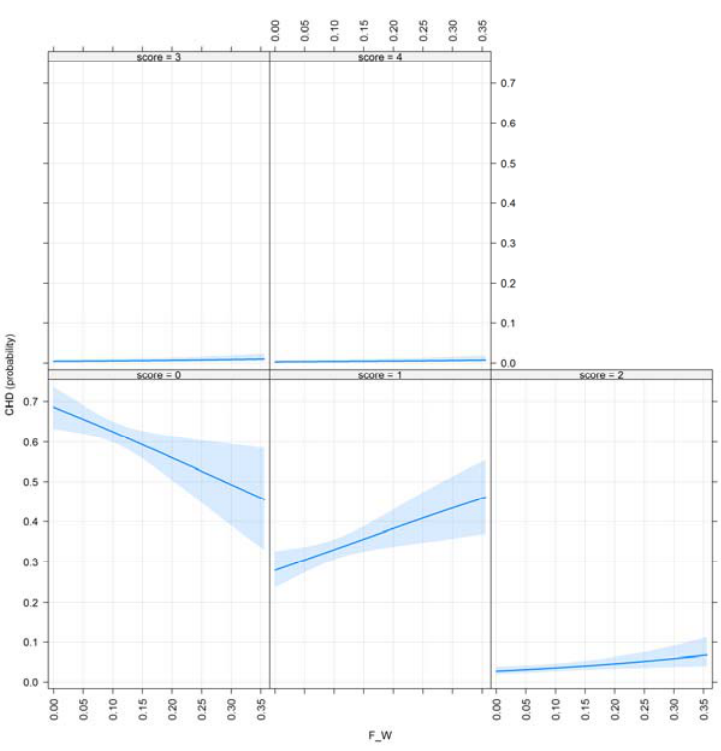
Figure 4. Effect plot of F _W for CHD, where scores from 0–4 illustrate hip results from A to E. Figures 5 and 6 demonstrate the effect plots for F _KAL and F _KAL_NEW.